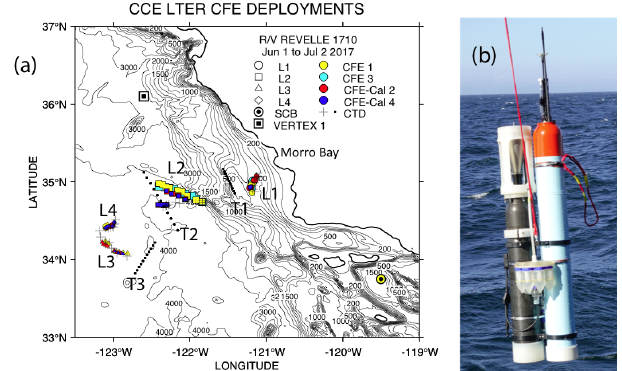
Figure 2. (a) CFE and CTD deployments at locations L1 to L4. The CTD stations were close to a drifting surface-drogued produc- tivity array. For the majority of stations, the CTDs and CFEs were close to one another. However, at L2, the CFEs diverged to the west- northwest of the drogued drifters. Dots depict locations of cross- filament CTD particle–optics transects T1, T2, and T3. T1 preceded work at L1; T2 was occupied after completion of sampling at L2. T3 was completed after work at L4. Data from transects shown in Fig. 11. (b) CFE-Cal during recovery.